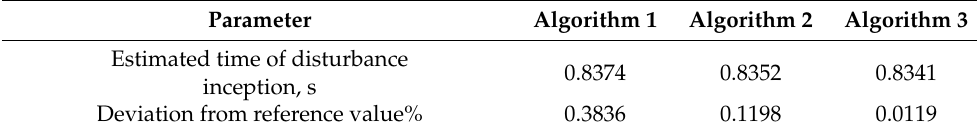
Table 4. Results of inception time estimation for the physical